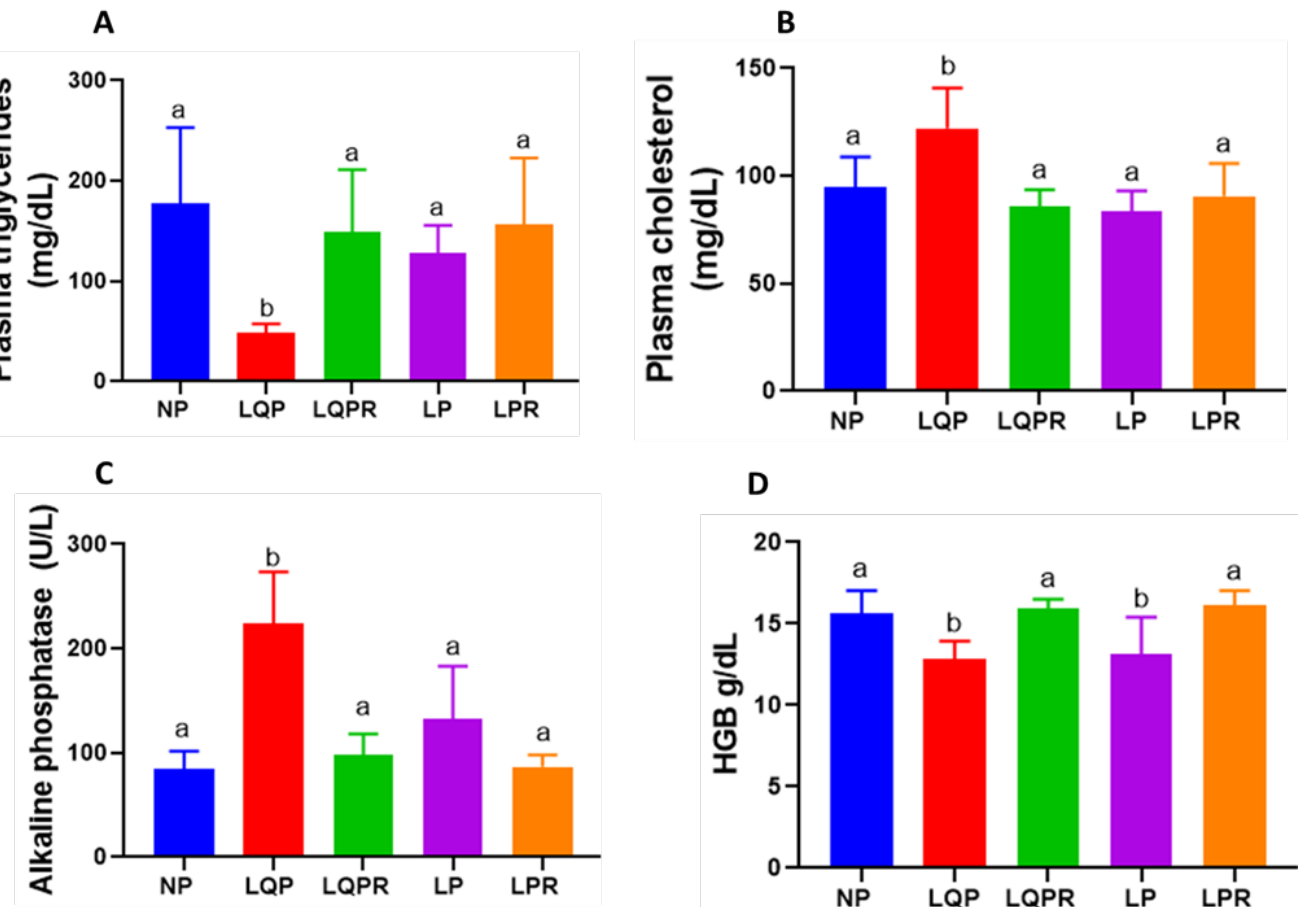
Figure 4. Effect of maternal protein restriction followed by rehabilitation on the lipid profile, alkaline phosphatase (ALP), and hemoglobin (Hb) in the offspring: the lipid — including triacylglycerides (TAG), cholesterol, and ALP in the plasma and Hb in the total blood of the offspring — was estimated at the end of the experiment. ( A ) TAG levels, ( n = 8 per group), ( B ) cholesterol levels ( n = 8 per group), ( C ) ALP levels ( n = 8 per group), and ( D ) Hb levels ( n = 8 per group, except NP; n = 7). The bars indicate the mean ± SD, and the bars that have different superscript letters differ significantly ( p < 0.05). NP, normal protein; LQP, low-quality protein; LQPR; low-quality protein group rehabilitated with the NP diet; LP, low protein; LPR, low-protein group rehabilitated with the NP diet.